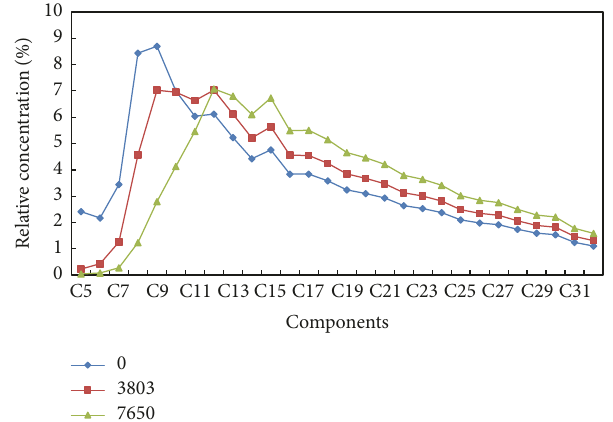
Figure 3: Relative concentration of produced oil at different time in the homogeneous